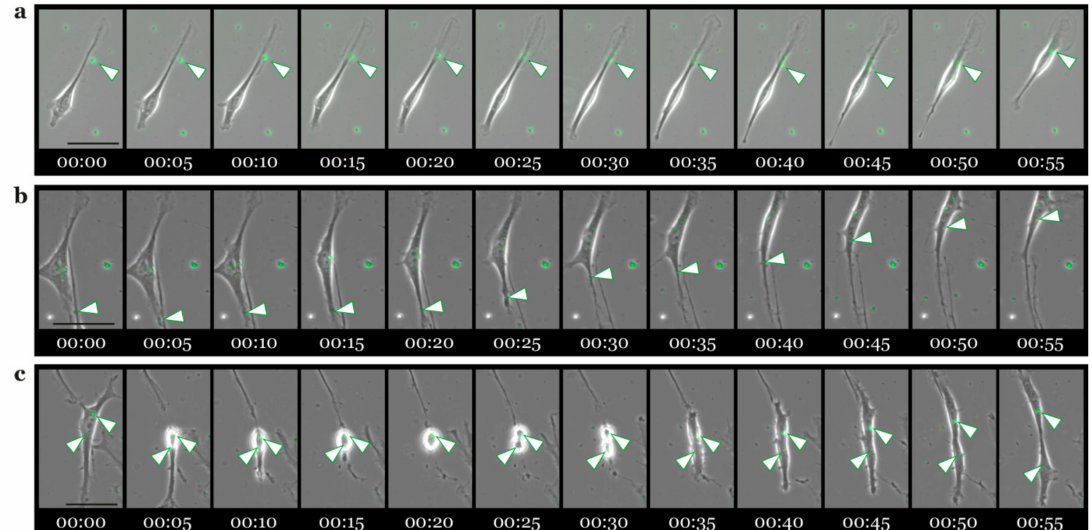
Figure 6. Live cell imaging of rSCs treated with rADSC-EVs. The Live cell imaging series in ( a , b ) visualize the binding and uptake of rADSC-EVs at the rSC processes followed by their transport to the cell body. The Live cell imaging series in ( c ) depict a dividing rSC with internalized rADSC-EVs. Scale bars in ( a – c ) represent 50 µ